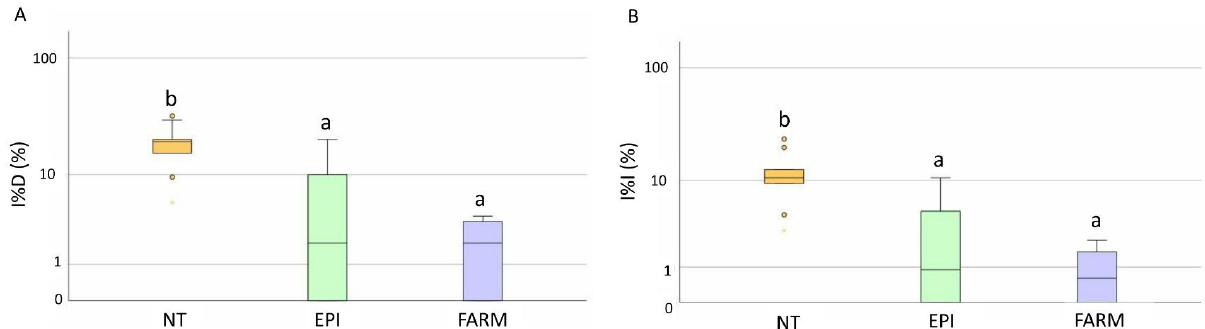
Figure 3. Box plot distribution of the final downy disease incidence (I%D) ( A ) and the severity (I%I) ( B ) registered in 2020 on bunches in the untreated (NT), EPI (EPI), and farmer’s strategy (FARM) plots. Different letters indicate significant differences among samples ( p < 0.05).